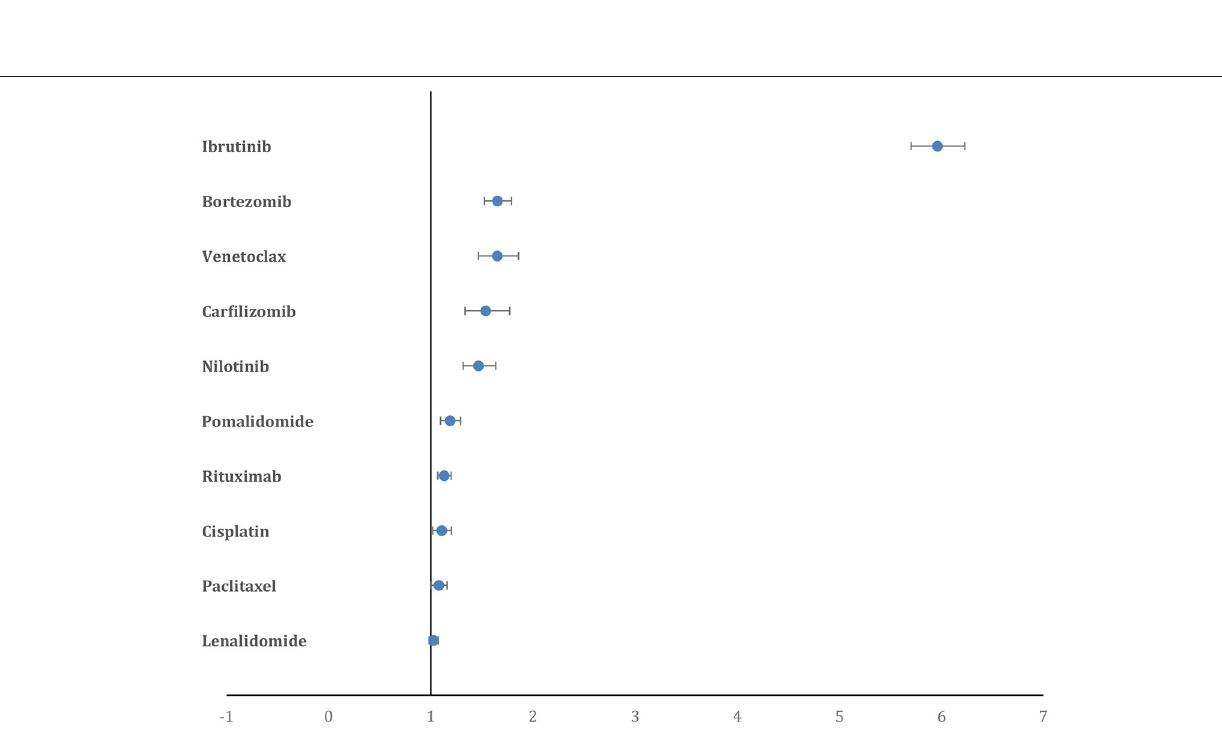
Frontiers in Cardiovascular Medicine |